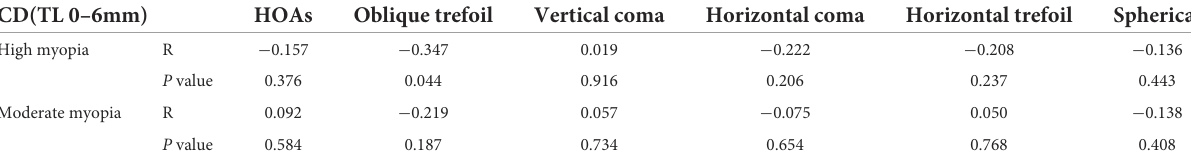
TABLE 5 Correlation between total corneal densitometry (0-6mm annulus) and corneal wavefront aberrations at last